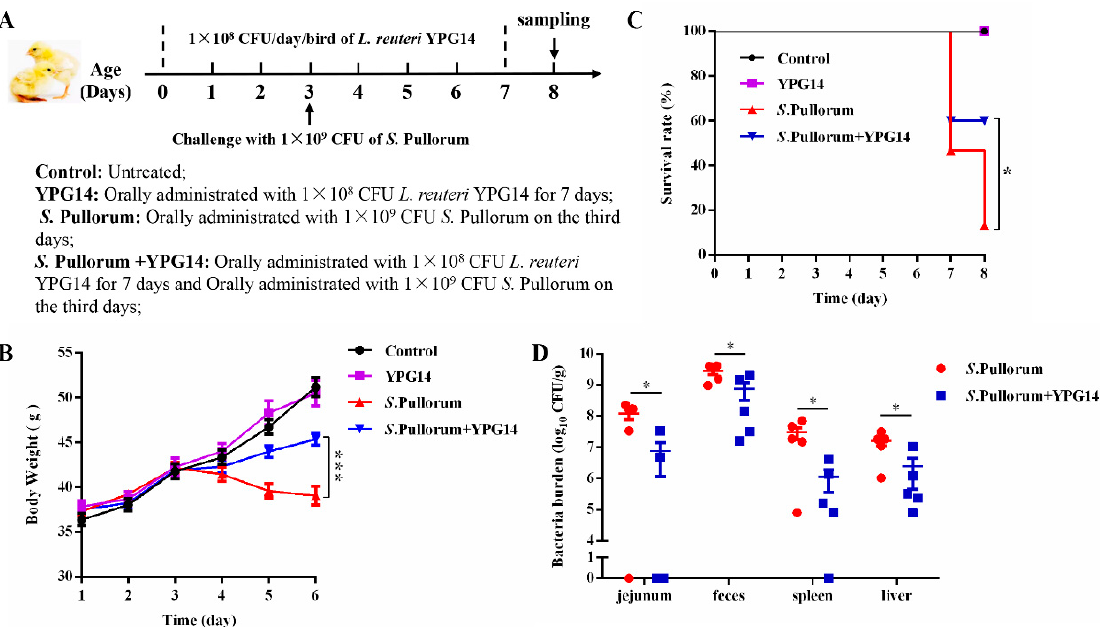
Figure 7. Study design and protective effect of the strain YPG14 against Salmonella Pullorum infections. ( A ) The experimental design and treatment procedure; ( B ) The determination of body weight change ( n = 15/group); ( C ) The determination of survival rate ( n = 15/group); ( D ) The determination of S . Pullorum bacterial burden in tissues and feces infected with S . Pullorum on 5- day post-infection (dpi). All data are shown as mean ± SEM. Student’s t-test was performed. Statistical significance is indicated by * p < 0.05 and *** p <